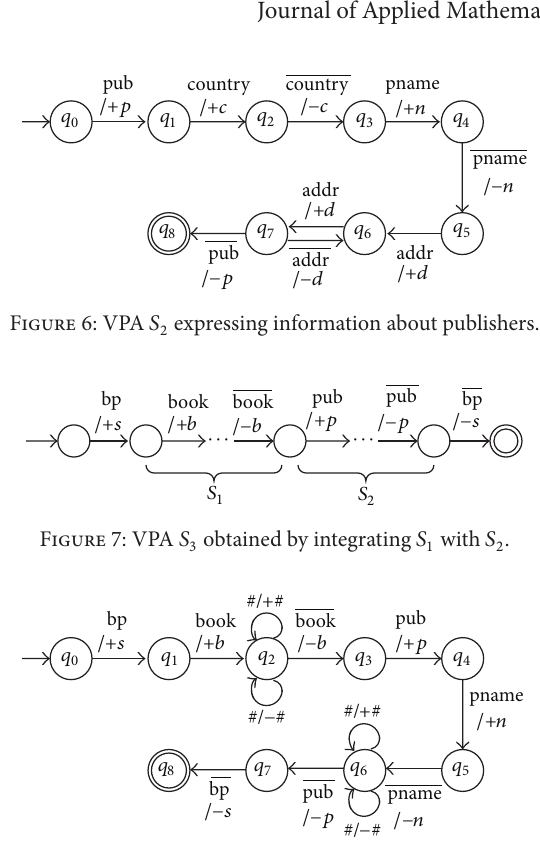
Figure 8: VPA 𝑇 expressing a target XML